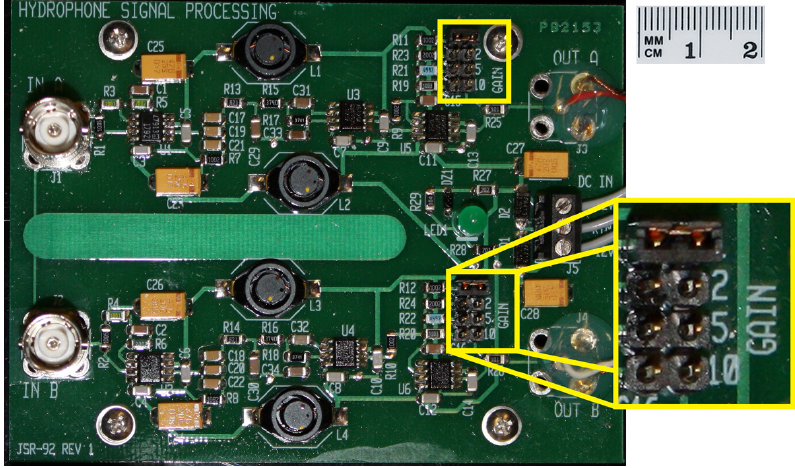
Figure 3. Hydrophone signal processing board. The gain selector jumper pins for each channel are highlighted in